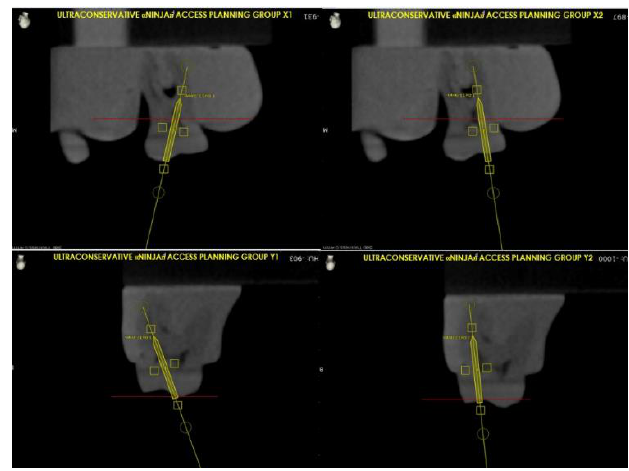
Figure 2. The locations of each different PEAC of Figure 1 are represented on the occlusal surface of the tooth with the same colors.